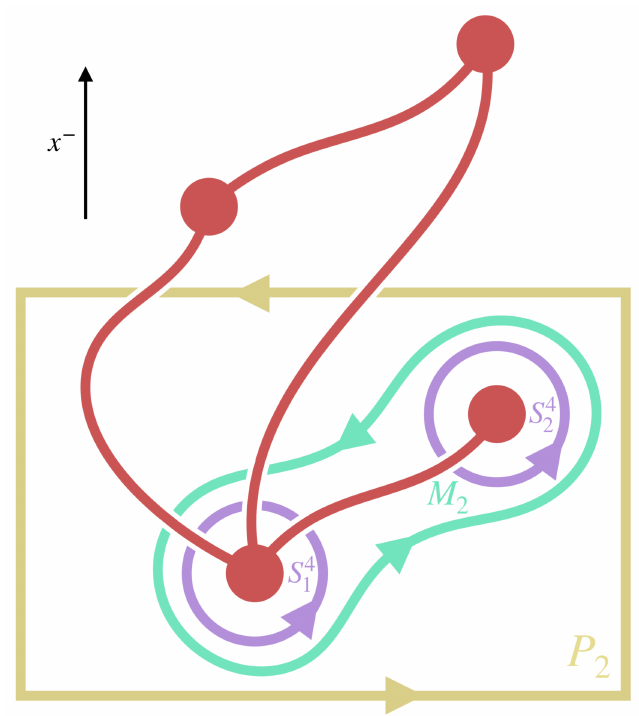
, ∪ S 4 1 2 that is only pierced by 2 ) + Q ( S 4 ) = 1 2